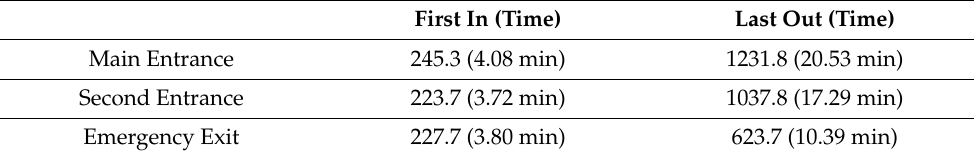
Table 6. Time spent by the first and last occupants for Scenario 3 in Simulation